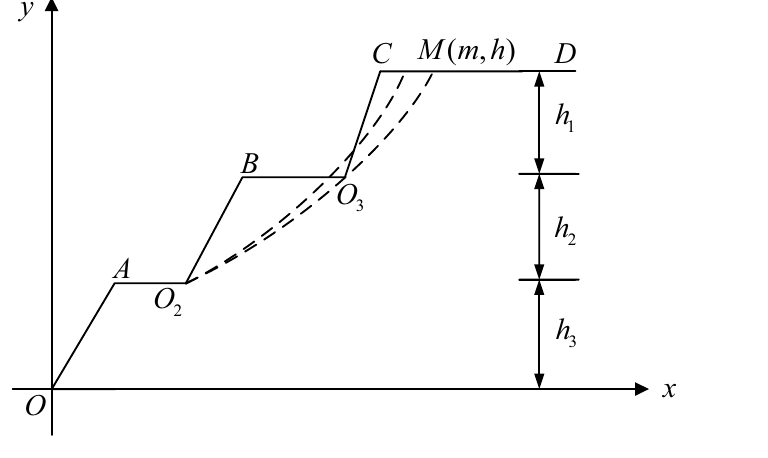
Figure 3. Schematic diagram of broken